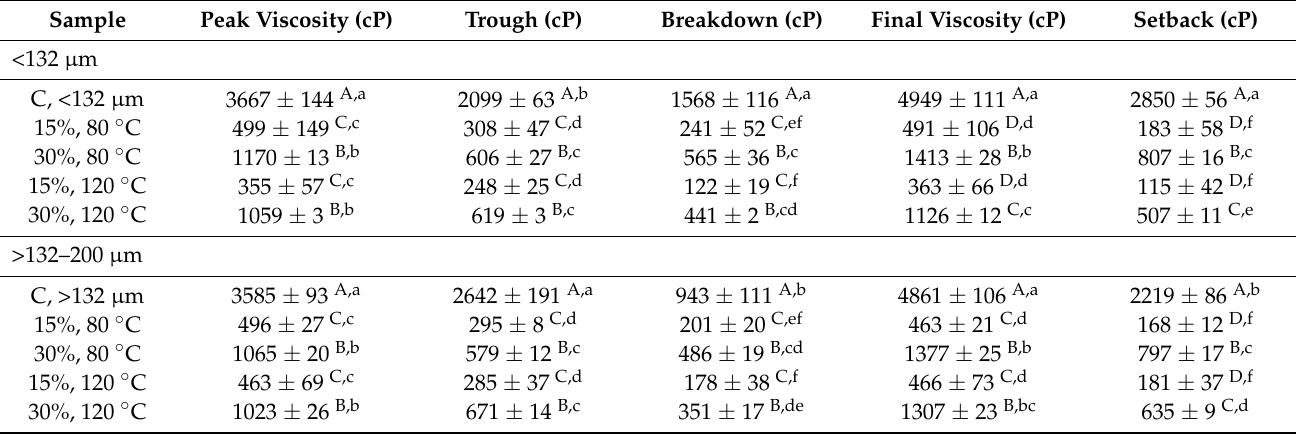
Table 2. RVA measurement